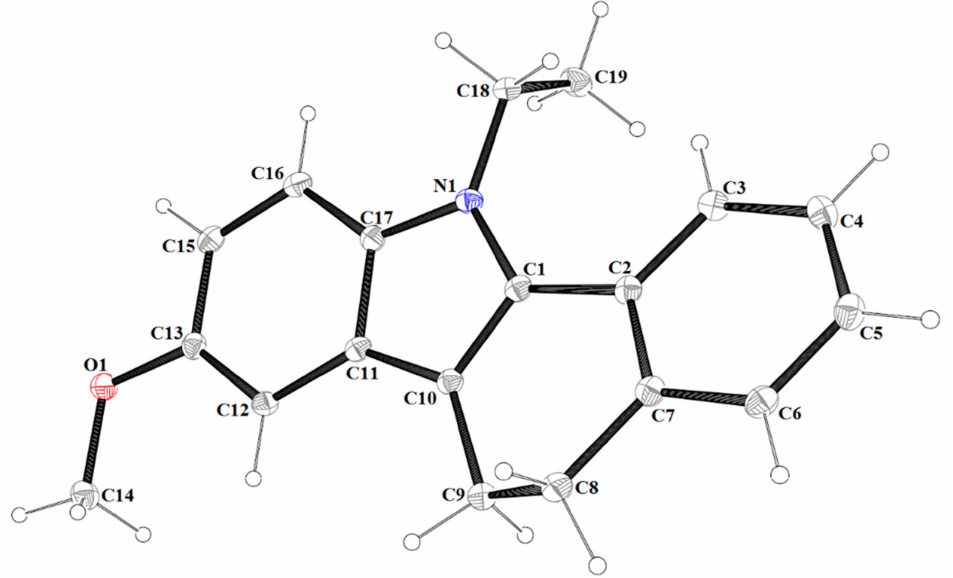
Figure 4. A view of asymmetric unit of 3 , showing the atom-numbering scheme. Displacement ellipsoids are drawn at the 30% probability level.